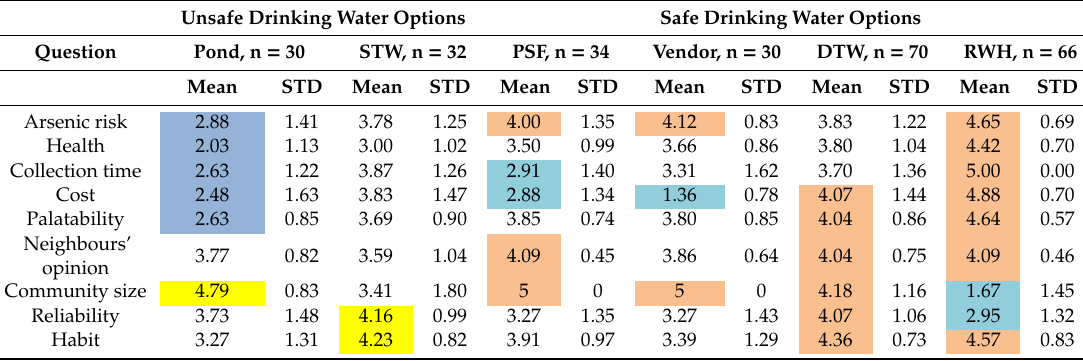
Table A1. Standardised mean values for the answers to the di ff erent questions. For the unsafe drinking water options, the facilitators (values lower than 3) are highlighted in blue, while the barriers (values higher than 4) are highlighted in yellow. For the safe drinking water options, barriers (values lower than 3) are highlighted in orange, while opportunities (values higher than 4) are highlighted in